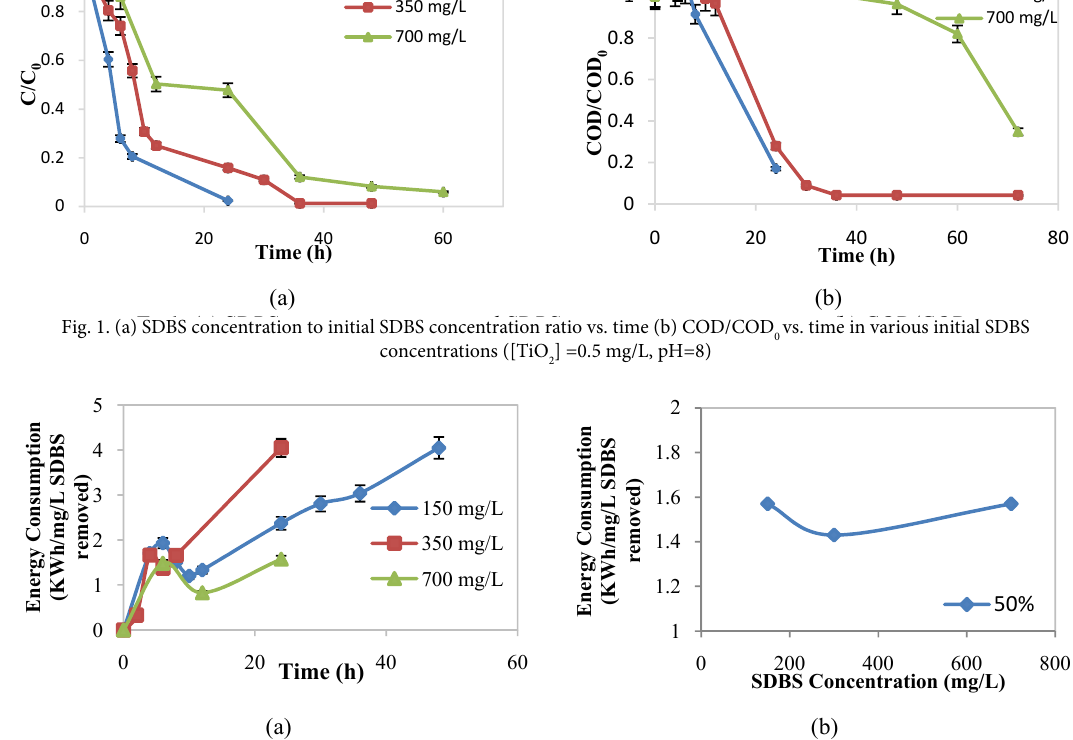
Fig. 2. (a) Energy consumption vs. time (b). Energy consumption vs. SDBS concentration at 50% removal efficiency ([TiO 2 ] =0.5 mg/L, pH=8)